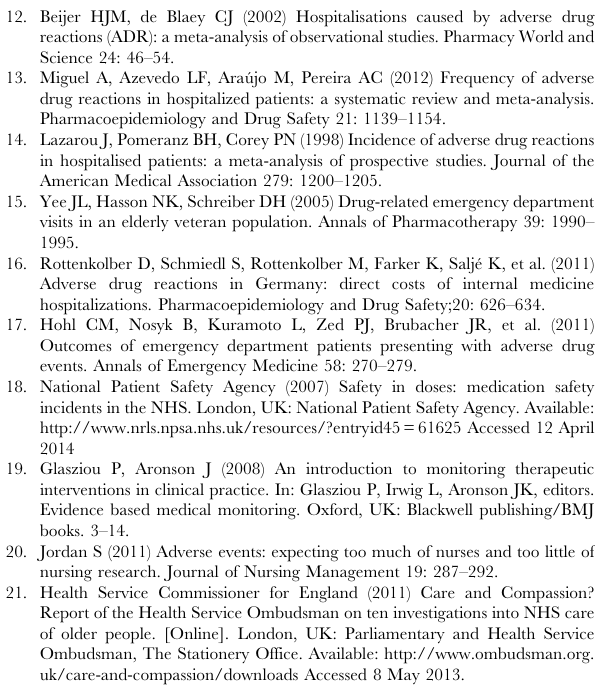
Protocol S1 Trial Protocol: Nurse-led medication mon-